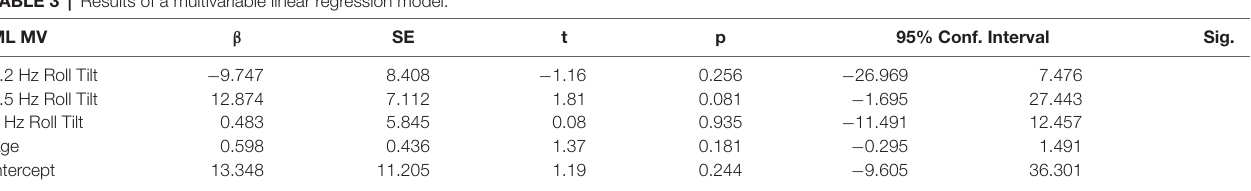
TABLE 3 | Results of a multivariable linear regression model. ML